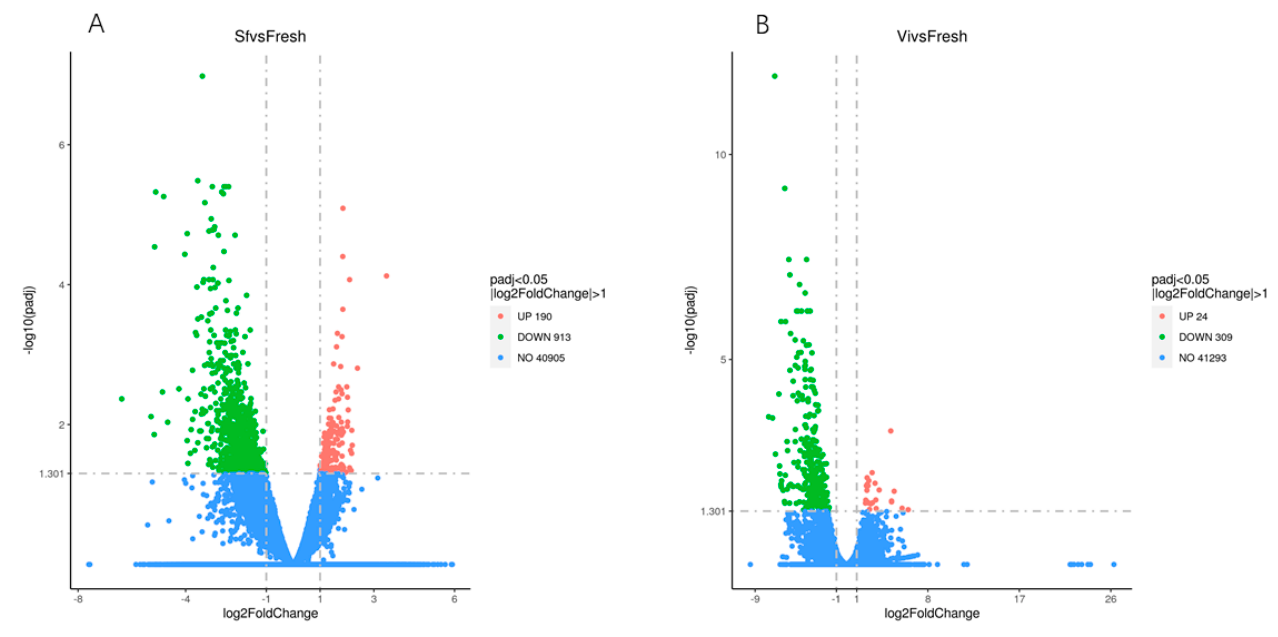
Figure 1. The differential expression genes level in Slow freezing ( A ) and Vitrification ( B ) groups.